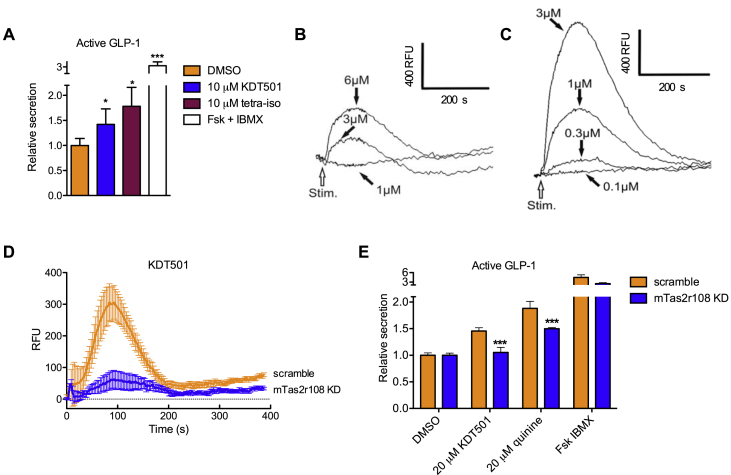
KDT501 signals through the bitter taste receptor mTas2r108. (A) Secretion of active GLP-1 into media from STC-1 cells exposed to the indicated compounds for 1 h. Forskolin (20 μM)/IBMX (100 μM) cocktail serves as positive control (n = 3). Representative intracellular calcium traces (n = 3) induced by KDT501 in HEK293 cells stably-expressing a Gα15-gustducin chimera and transiently transfected with (B) mouse Tas2r108 or (C) human TAS2R1. Calcium traces are shown after mock subtraction; RFU = relative fluorescence units. (D) Intracellular calcium mobilization response to KDT501 (10 μM) in STC-1 cells stably-expressing scramble shRNA or shRNA targeting Tas2r108. The response to KDT501 is abolished in cells depleted of Tas2r108 (n = 6). (E) Secretion of active GLP-1 in Tas2r108 knockdown STC-1 cells. Data presented as means ± SD in A and E, and means ± SEM in D. Statistical significance was calculated using Student's t test in A, and two-way ANOVA in E. *p < 0.05, ***p < 0.005 relative to vehicle-treated or Tas2r108 knockdown cells.